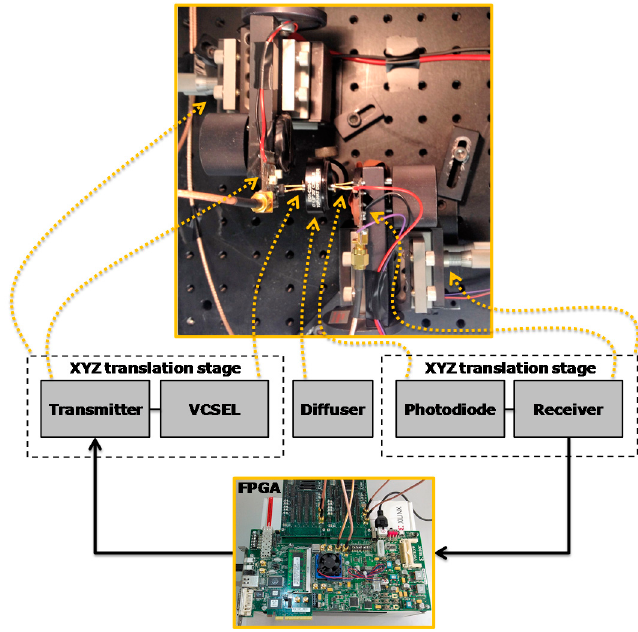
Figure 5. Experimental set-up: picture of the overall implemented system and the related block scheme showing its main components.